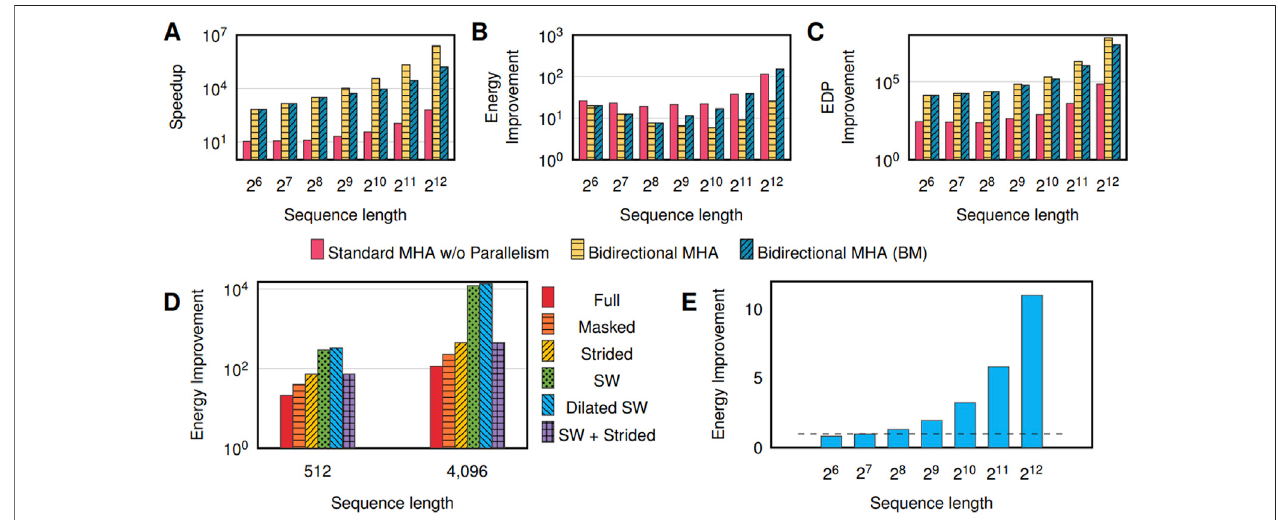
FIGURE6| ComparisonbetweenCMOS-basediMTransformerandGPUBaselineintermsofthespeedup (A) ,energy (B) andEDP (C) evaluationresultsformulti- head attention (with and without parallelism) for varying sequence length. Energy improvementsofMHA without parallelism forlocality-based (D) and content-based (E)